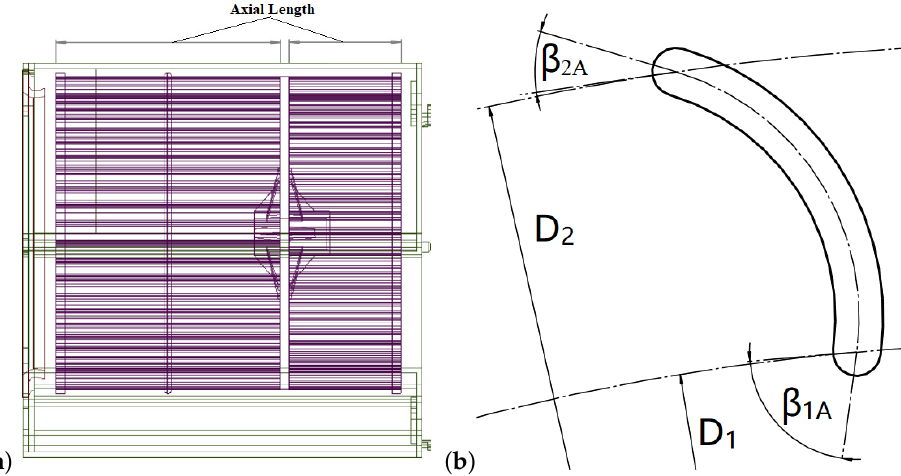
Figure 15. Geometric parameters of each impeller in optimization: ( a ) axial length, ( b ) blade